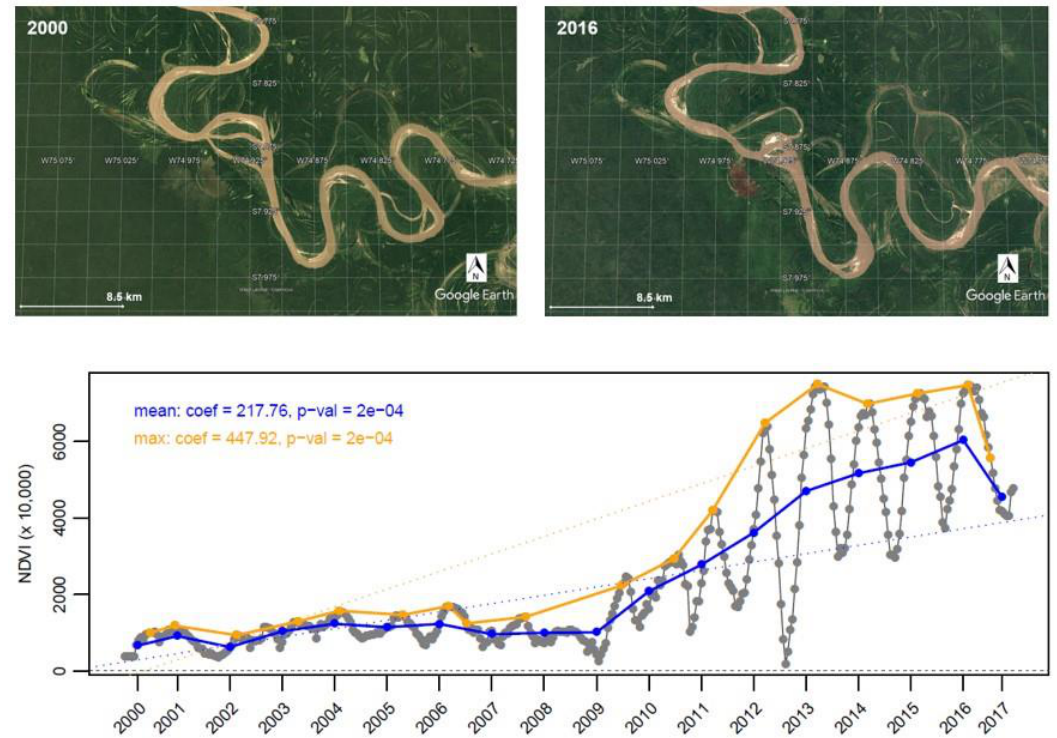
Figure 10. In the upper panels, high spatial resolution imagery from Google Earth Pro shows Amazon greening downriver from Pucallpa between 2000 and 2016. Deposition of sediment creates substrates on which forest succession can occur and appears as a positive NDVI trend. The accompanying graph shows the entire time-series of the NDVI data and fitted Thiel-Sen trends for NDVI-mean (blue) and NDVI-maximum (orange) for a pixel located at S 7.874447 ◦ , W 74.916197 ◦